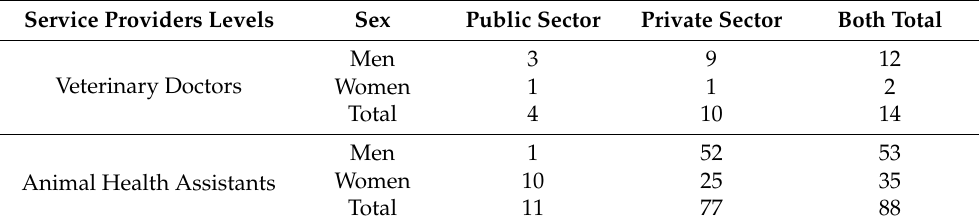
Table 3. Staffing of the veterinary services in Machakos County. Service Providers Levels Sex